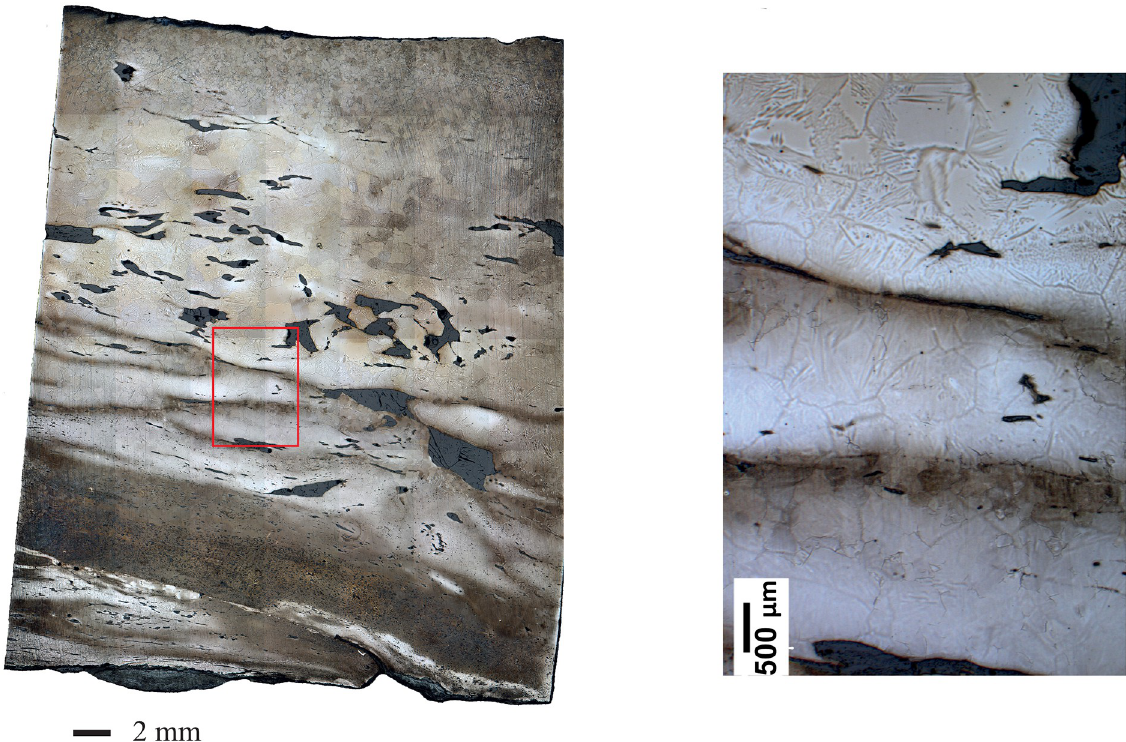
Fig 11. Oberhoffer etching on sample NN9-T showing mesoscopic and microscopic variation in P content (the lighter zones are richer in P).